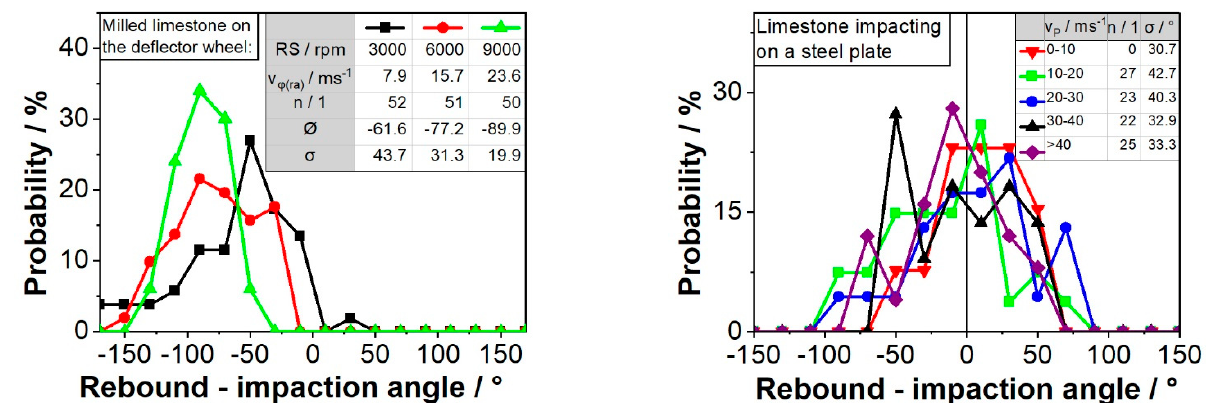
Figure 8. ( Left ) Probability distribution of rebound angle minus impaction angle measured for limestone impacting on the paddles of the aluminum deflector wheel and ( right ) probability distribution of rebound angle minus impaction angle measured for limestone particles impacting on a steel plate in the test bed. RS stands for rotor speed, v φ (ra) for the rotor speed at the outer radius, n for the number of evaluated particles, Ø for the mean rebound–impaction angle, and σ for the standard deviation.